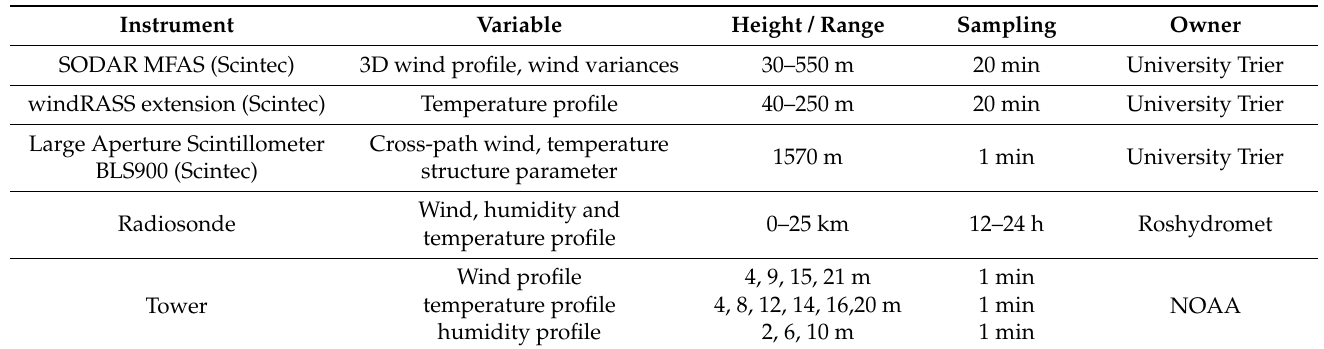
Table 1. Instruments and measurements at Tiksi during the